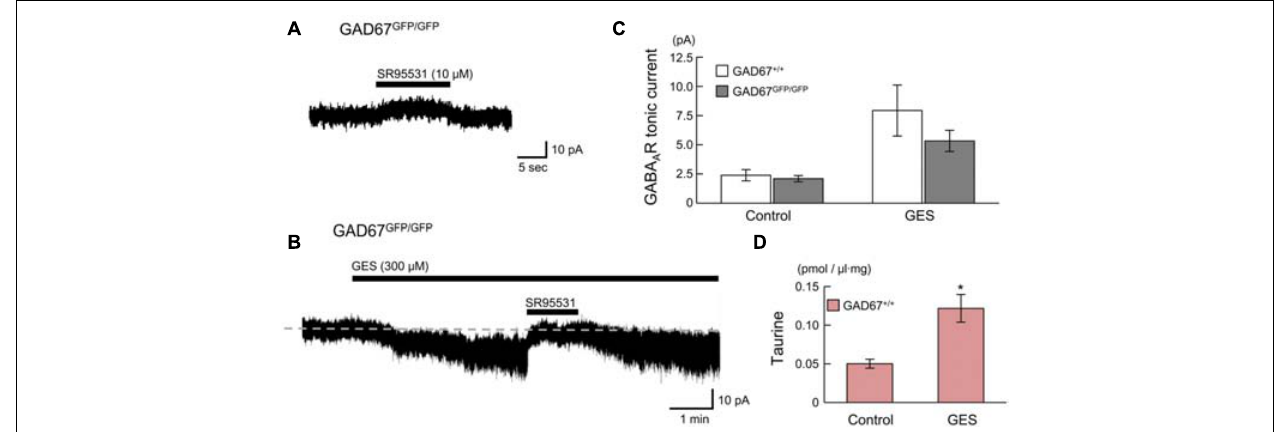
FIGURE 7 | GABA A Rs in radially migrating neurons are activated by endogenous taurine. (A) Typical trace of a GABA A R-mediated tonic current in an RFP-positive cell in the SP under normal conditions. V H was − 60 mV. (B) SR95531-sensitive inward current induced by the application of GES.The baseline currents immediately before (for 5 s) the initiation and the cessation of SR95531 application were averaged, to determine the tonic currents based